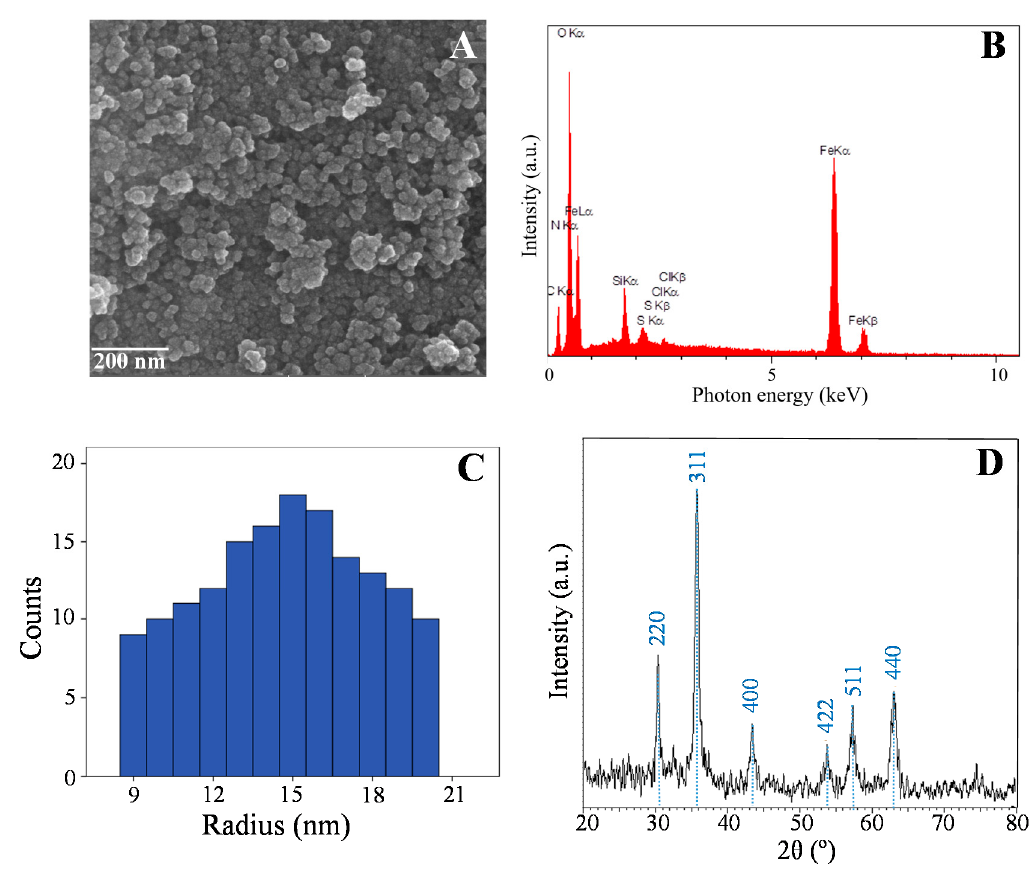
Figure 1. ( A ) Scanning electron microscope (SEM) image, ( B ) energy-dispersive X-ray spectroscopy (EDX) spectrum, ( C ) Particle size distribution and ( D ) X-ray diffraction (XRD) patterns of γ -Fe 2 O 3 /SiO 2 -STZ. Table 1. Elemental distribution (atomic %) of γ -Fe 2 O 3 /SiO 2 -STZ. Sample Fe O Si C Cl S N Total γ -Fe 2 O 3 /SiO 2 -STZ